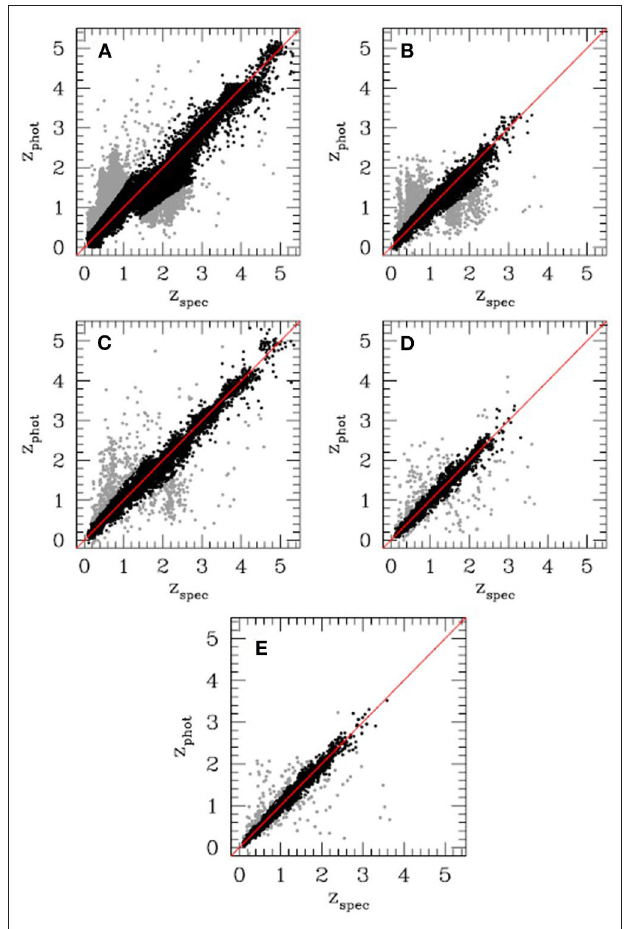
FIGURE 4 | Figure from Brescia et al. (2013). Scatter plots of photo-z predictions for QSOs referred to the multi-band photometry using bands from, respectively, (A) SDSS, (B) GALEX + SDSS, (C) SDSS + UKIDSS, (D) GALEX + SDSS + UKIDSS, and (E) GALEX + SDSS + UKIDSS + WISE. Gray points are catastrophic